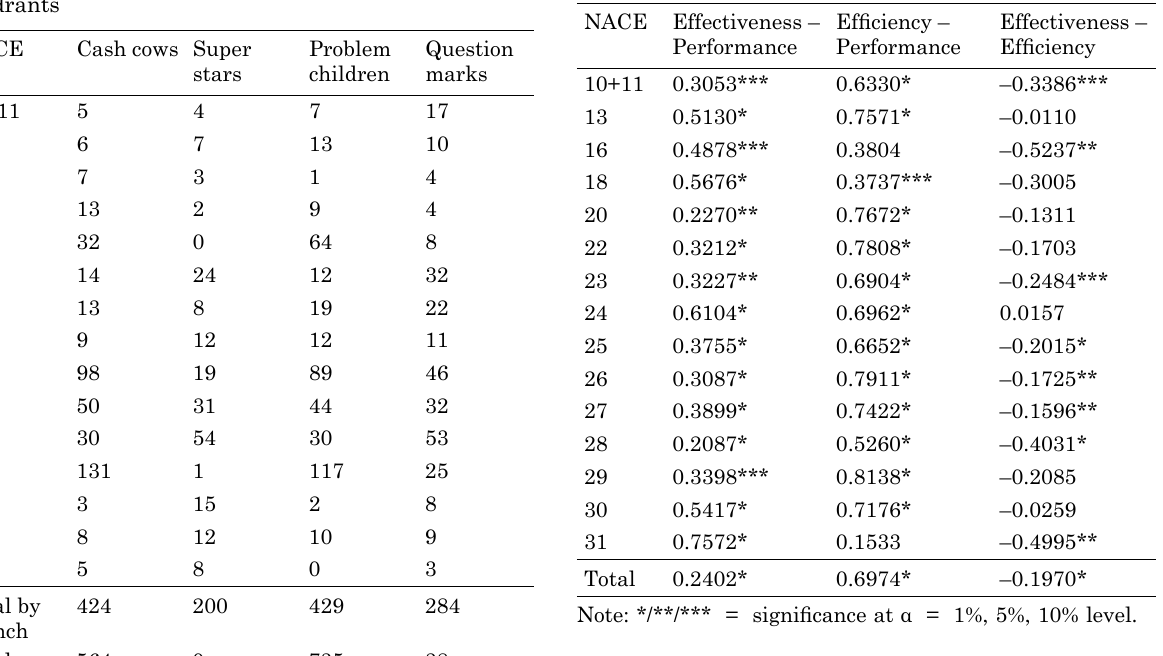
Table 3. number of companies in each matrix Table 4. Pearson product moment